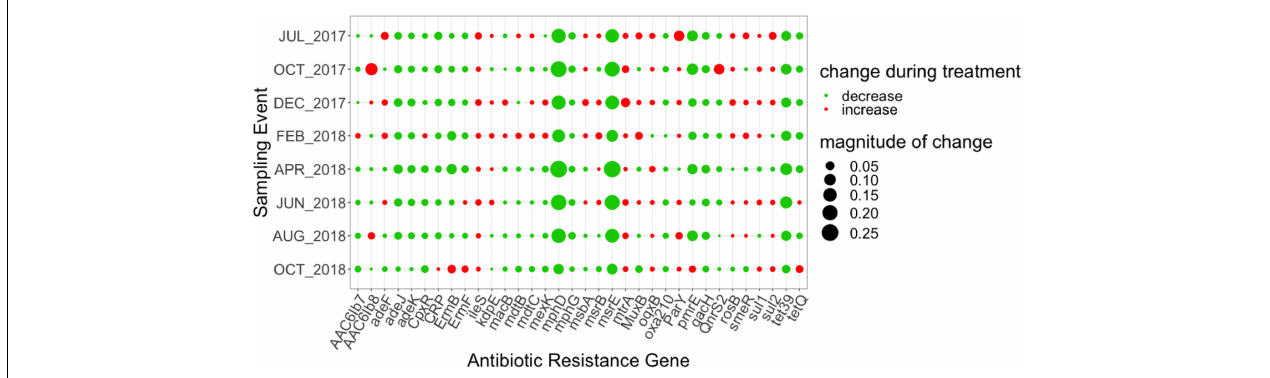
FIGURE 3 | Magnitude of change (based on absolute difference) in relative abundance between influent and secondary effluent of top 34 ARGs pertaining to the core resistome (ARGs detected across each treatment process and all sampling events). Change was calculated as the difference between the relative abundance of the secondary effluent and the relative abundance of the